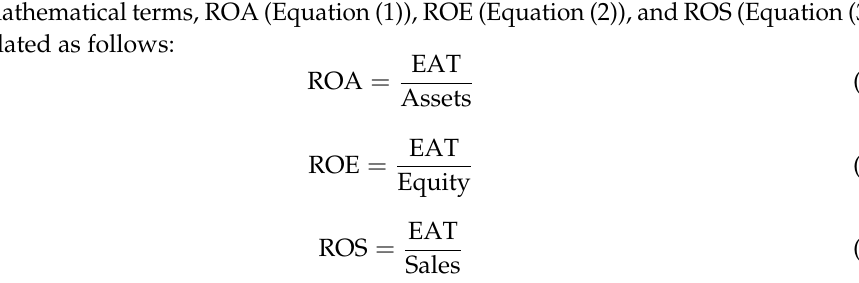
Figure 4. Select profitability measures. Source: own research .